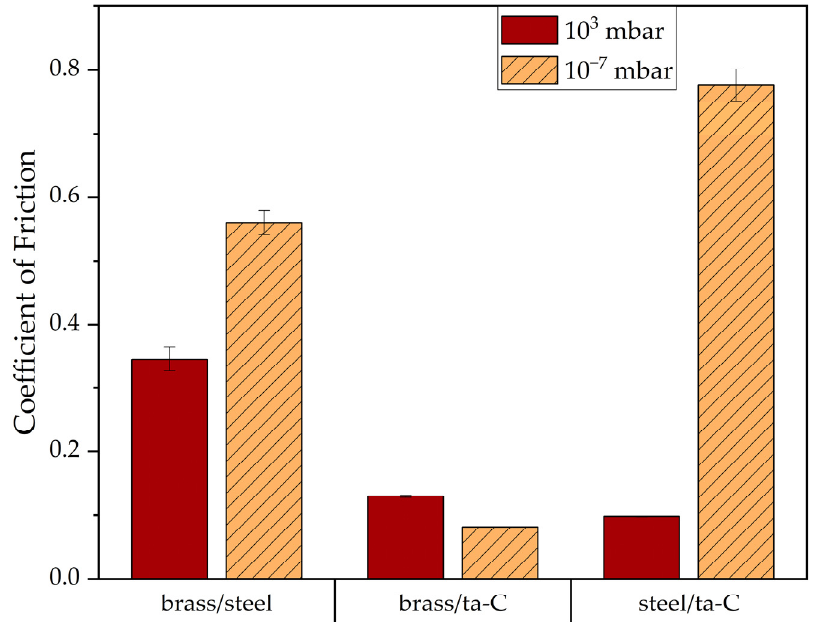
Figure 4. Steady-state friction coefficient of brass/steel, brass/ta-C, and steel/ta-C pairs at 10 3 mbar and 10 − 7 mbar. High-vacuum pressure/mbar: brass/steel: 5.0 × 10 − 7 ; brass/ta-C: 1.1 × 10 − 7 ; steel/ta-C: 2.0 × 10 − 7 .